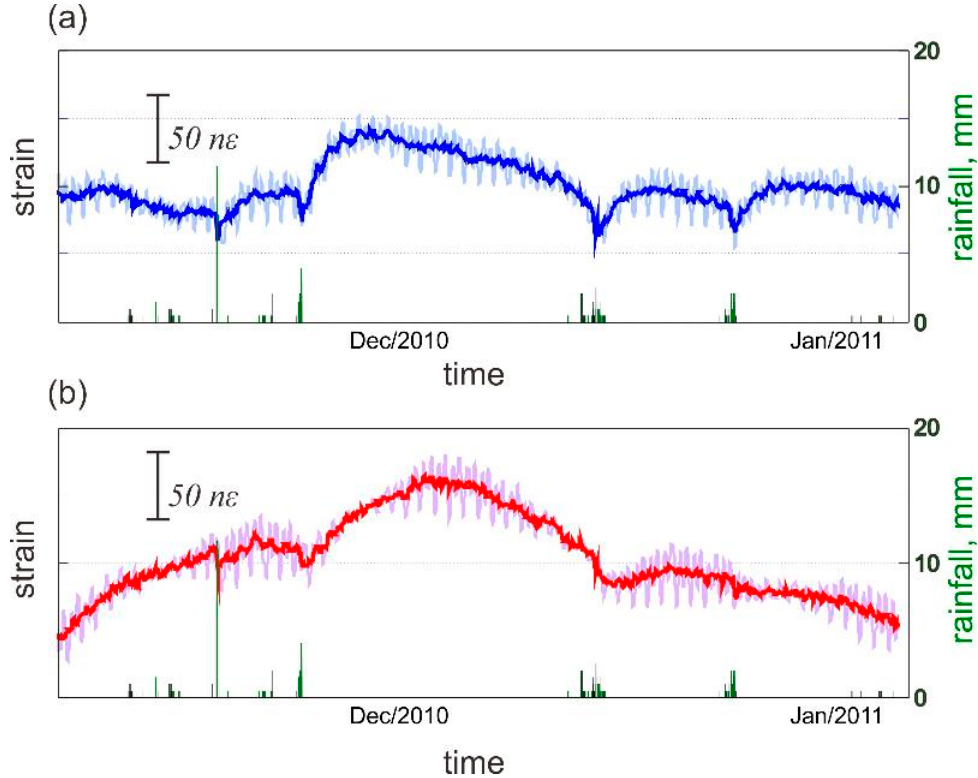
Figure 8. The diagram shows the results of calibrated areal strain in JING with the ( a ) isotropic coupling method and ( b ) vertical coupling method, respectively. The dark colored line means the vertical coupling method, respectively. The dark colored line means the result of removing tidal response, while lighter result of removing tidal response, while lighter color means no deal with tides. In some cases, the color means no deal with tides. In some cases, the rainfall responses clearly spotted in isotropic-coupling data show weaker rainfall responses clearly spotted in isotropic-coupling data show weaker or even difficult to be or even difficult to be identified after vertical coupling identified after vertical coupling calibration.